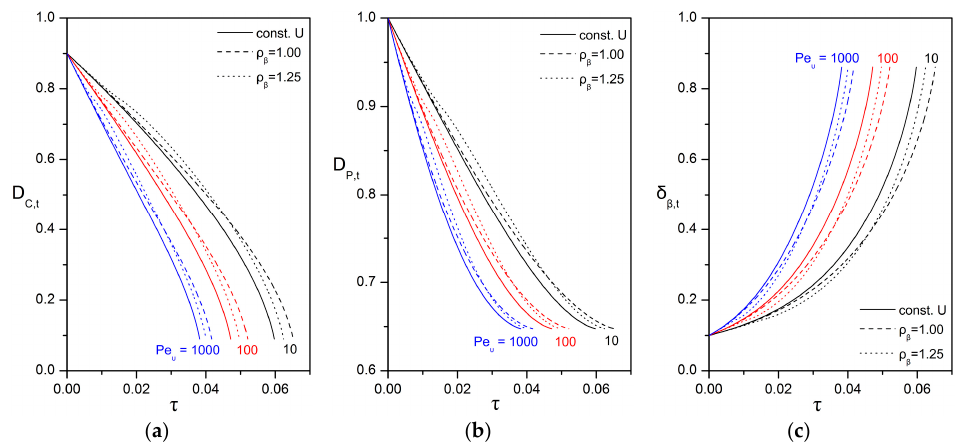
Figure 6. Impact of the velocity mode and the initial Péclet number on the evolution of: ( a ) the dimless diameter of the oily core; ( b ) the dimless diameter of the compound particle; ( c ) the dimless thickness of the biofilm shell. For each Péclet number, the continuous line corresponds to a compound particle that moves with constant velocity. For the free rise/fall mode: ρ β = 1.00 (dashed line); ρ β = 1.25 (dotted line). The values of the other parameters are: δ β ,0 = 0.1; h T = 0; Da υ = 0; Λ A β = 1; H A , υ / β = 1; k srn = 0; Y β / A = 0; ρ λ = 0.85.